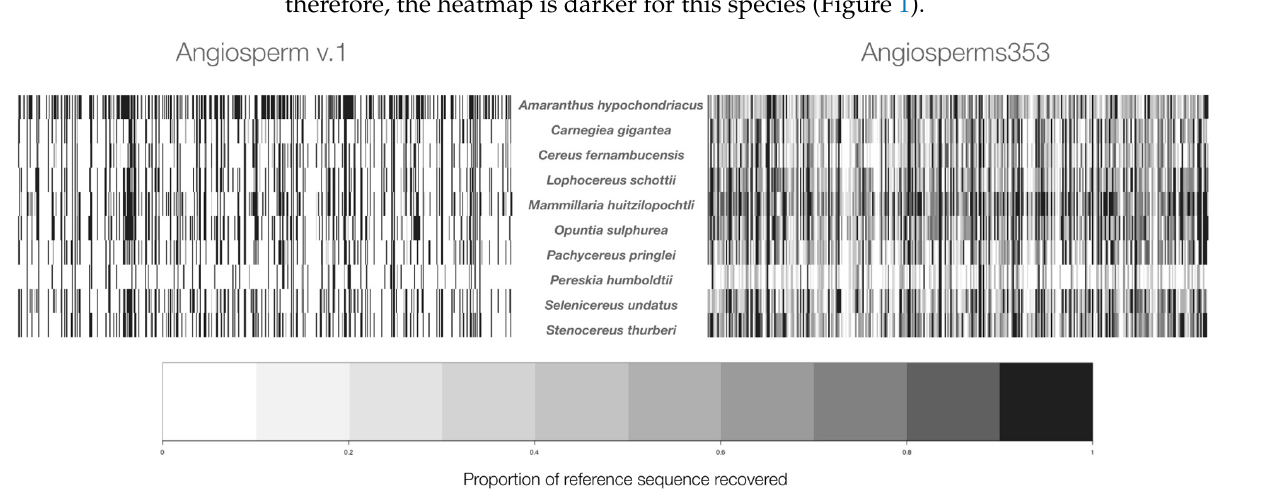
Figure 1. Heatmap per species is presented by raw data. To the left of the species names are the results obtained with Angiosperm v.1, and to the right, the results obtained with Angiosperms353. The gaps (white color) are caused by the absence of vertical lines, which indicates that the targeted DNA sequences did not find those loci in the genome tested. Table 1. Comparison of the four parameters used to estimate the effectiveness between the two probe sets in silico tested. The results outside parentheses correspond to results obtained with Angiosperm v.1, and those inside parentheses with Angiosperms353. Total number of loci recovered with each probe set; number of loci that found a proportion ≥ 50% of the length of the targeted DNA sequence; the total length (bp) of sequences identified as exons and the quotient calculated; total length of exons from Angiosperms353/length of exons from Angiosperm v.1; and the absolute number of paralogous loci identified per